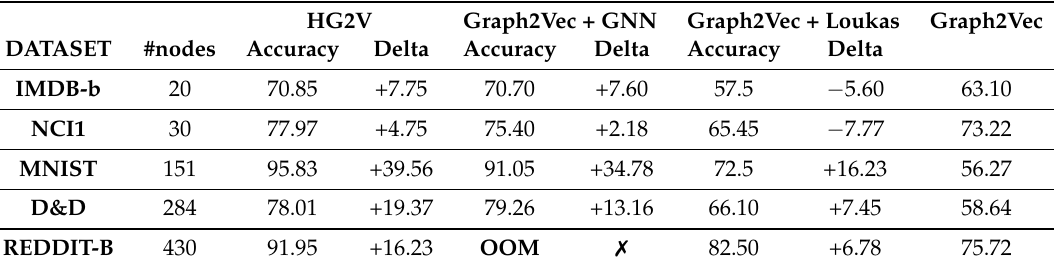
Table 4. Ablative studies. The accuracy on test set is in the column “Accuracy”. The column “Delta” corresponds to the difference in average accuracy with Graph2Vec. OOM —Out of Memory Error. HG2V Graph2Vec + GNN Graph2Vec + Loukas